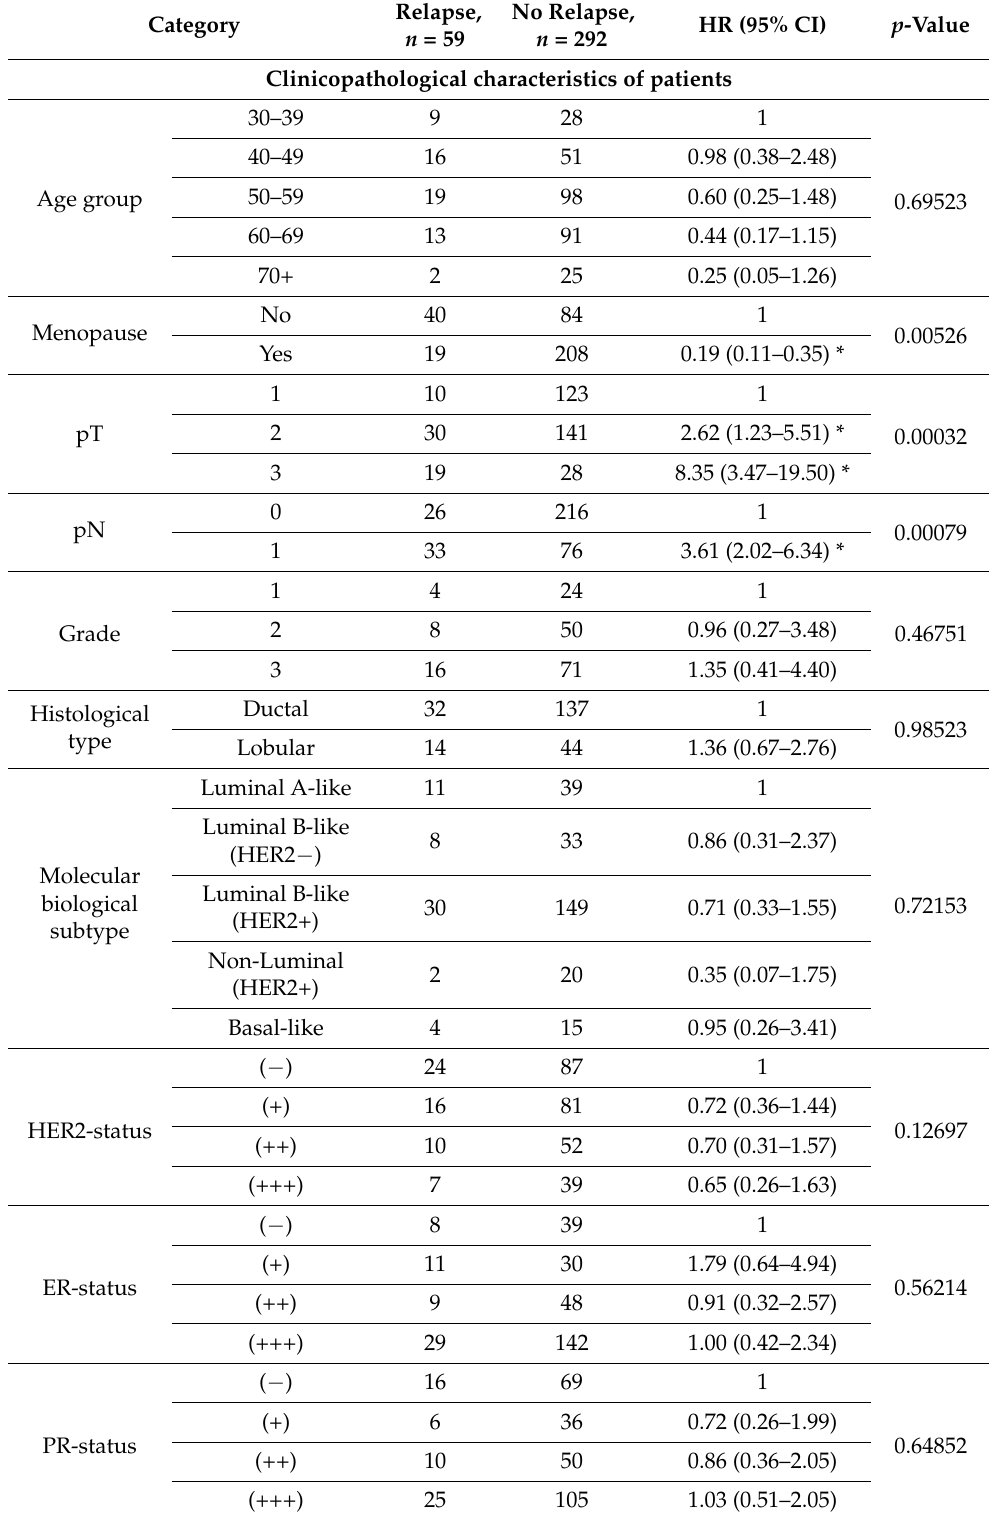
Table 5. The relative risk of relapse in patients with primary operable breast